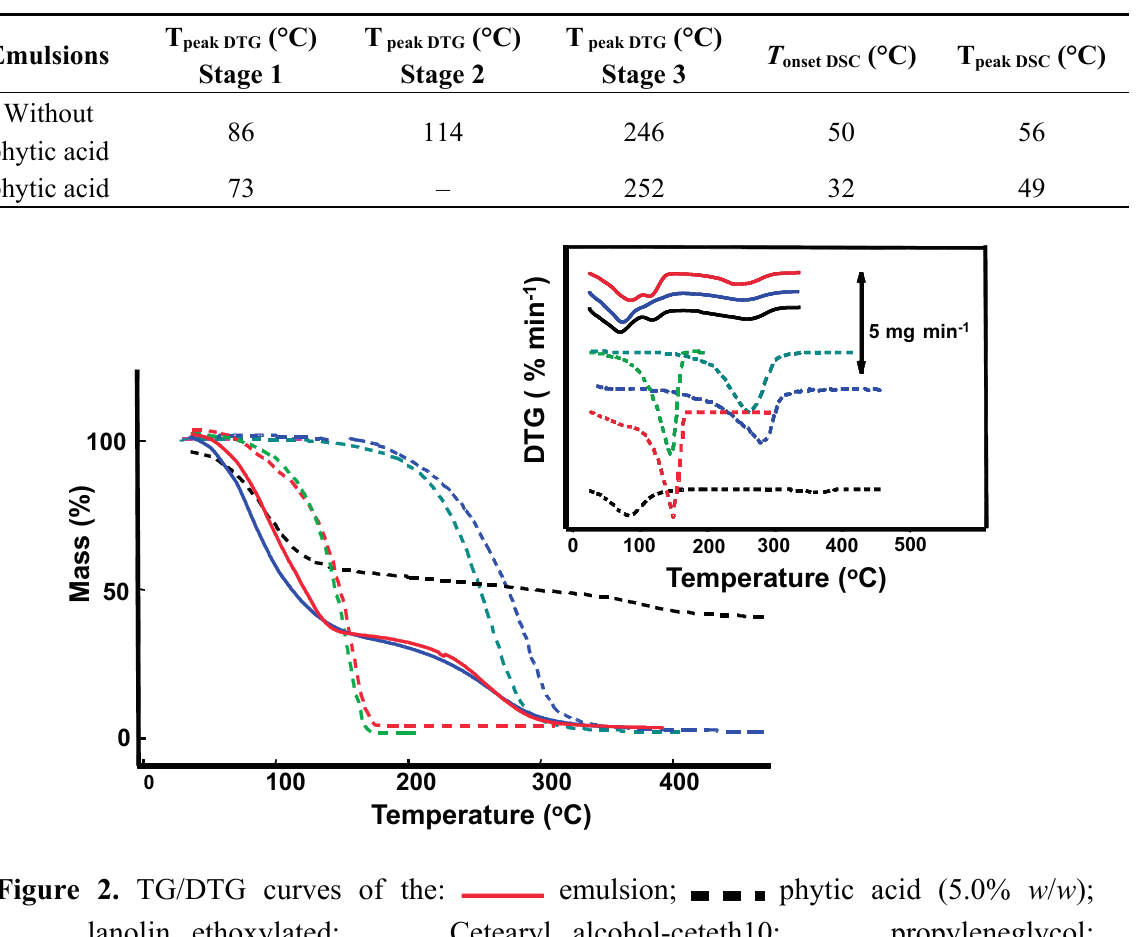
Figure 2. TG/DTG curves of the: emulsion; phytic acid (5.0% w / w ); lanolin ethoxylated; Cetearyl alcohol-ceteth10; propyleneglycol; cyclopentasiloxane; emulsion phytic acid 5.0% ( w / w